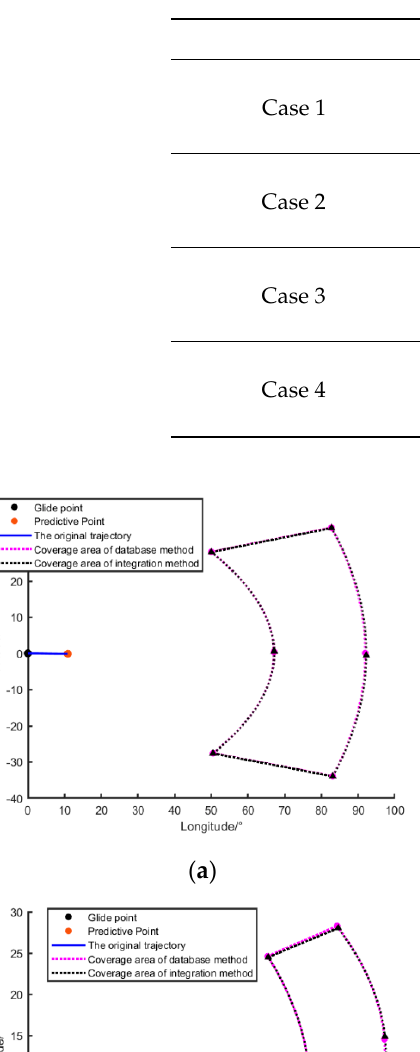
Table 6. Time consumed between TIM and DBM.